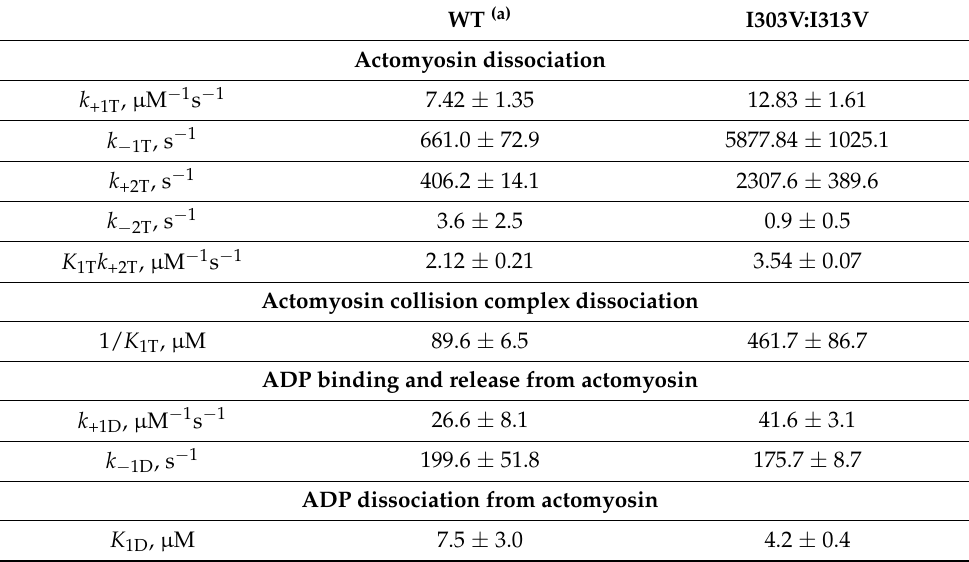
Figure 3. ATP-induced actomyosin dissociation. Squares, WT, data from [4], N = 3. Circles, mutant, N = 3. ( A ). Observed reaction rates at low [ATP], fitted with a straight line, the second-order reaction rate constant is determined from the slope of the line. WT and mutant, respectively, K 1T k +2T = 2.12 ± 0.21 μM −1 s −1 and 3.54 ± 0.07 μM −1 s −1 , p = 0.0029. ( B ). Reaction rates fitted with a hyperbola. Rates k +2T = 491.5 ± 74.1 s −1 and 1909.0 ± 354.8 s −1 , p = 0.0168, for WT and mutant, respectively. Equilibrium dissociation constant 1/ K 1T = 214.2 ± 24.9 μM and 506.2 ± 161.7 μM, p = 0.0738. Data points are mean ± SD. N is the number of biological replicates. Table 1 . Obtained kinetic rate constants. Results of the fit of the transients with the numerical solution of the system of differential equations (Supplementary Equations (S1) and (S2)), mean ± SD. The rate constant K 1T k +2T was obtained from the fit shown in Figure 3A. Data are averages of three independent protein preparations each for WT and mutant con- structs. WT (a) I303V:I313V